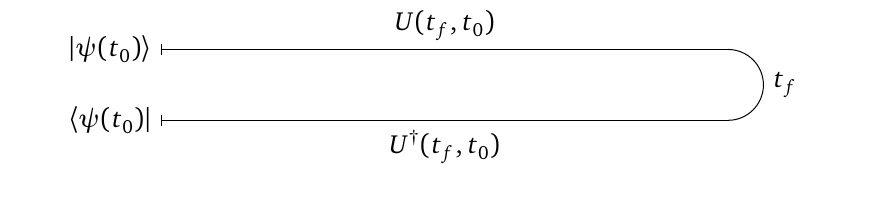
Figure 1: ‘Closed’ time